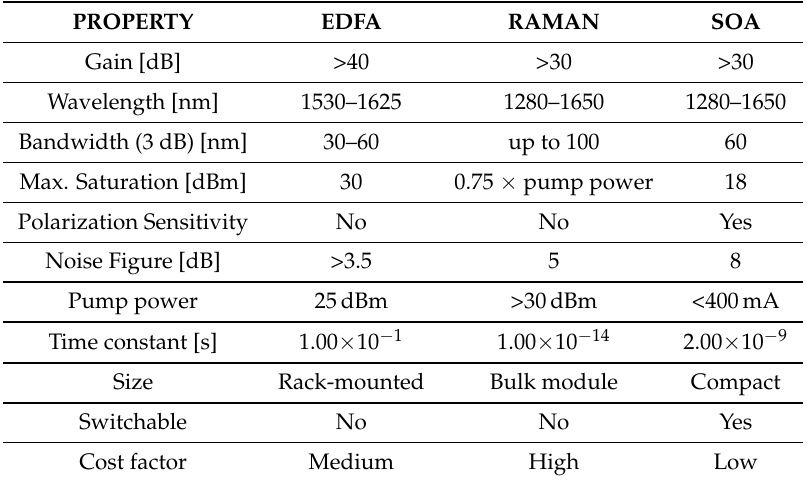
Table 2. Comparison of